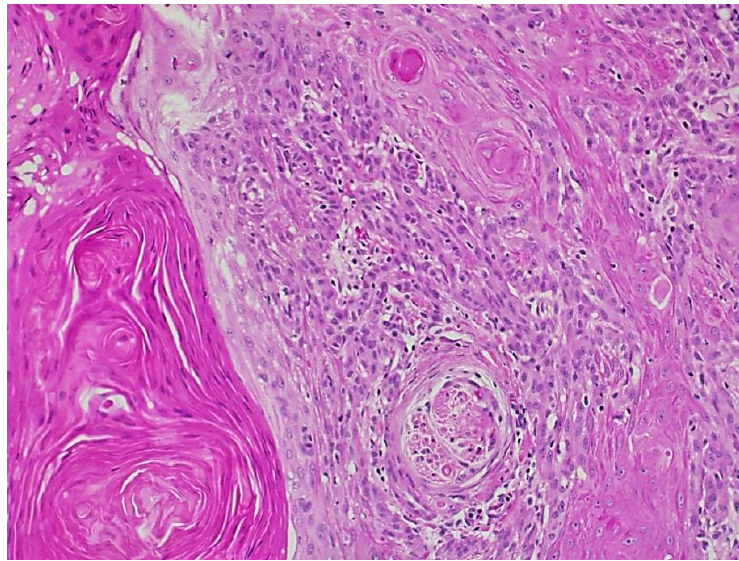
Figure 3. Squamous cell carcinoma with acantholytic features.